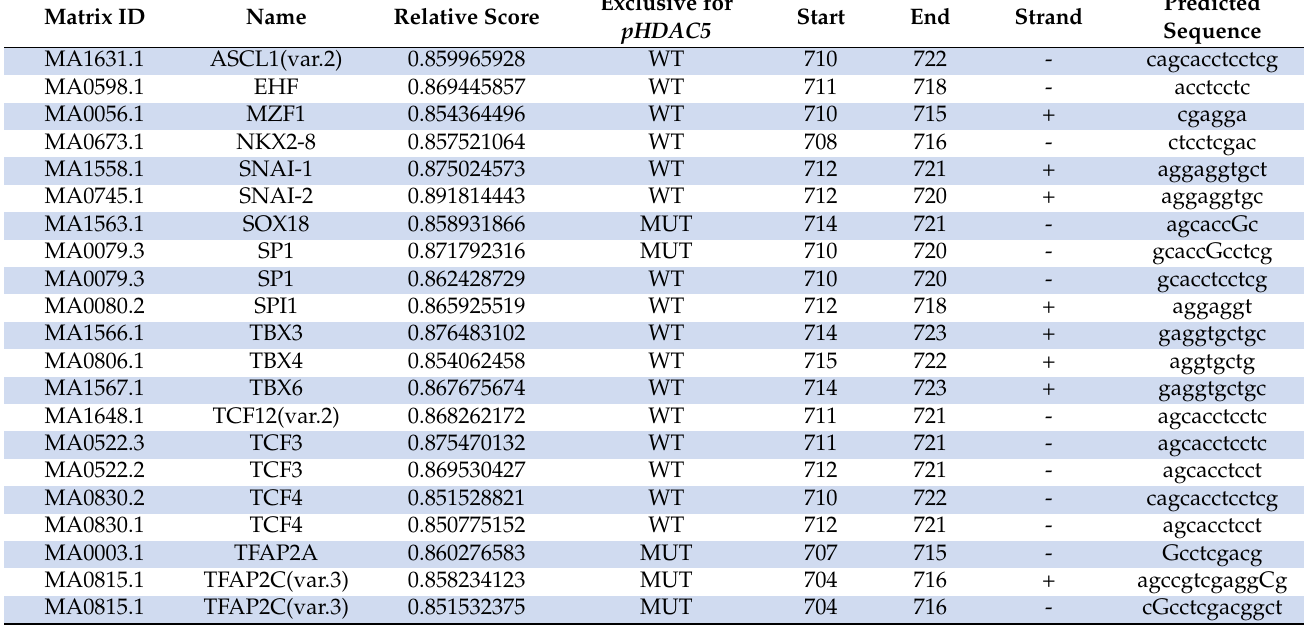
Table 4. Summary of transcription factor binding sites (TFBS) identified with Jaspar2020 and relative profile score threshold of 85% on 30 November 2020. Matrix ID, names of targeting transcription factors, relative scores, start and end position, strand information and respective binding sequences are included. A relative score of 1 represents the maximum likelihood sequence for the motif. TFBS newly created by the variant and thus exclusively present in HDAC5 MUT sequence are annotated as MUT , whereas TFBS destroyed by the variant and thus exclusively present in HDAC5 WT sequence are annotated as